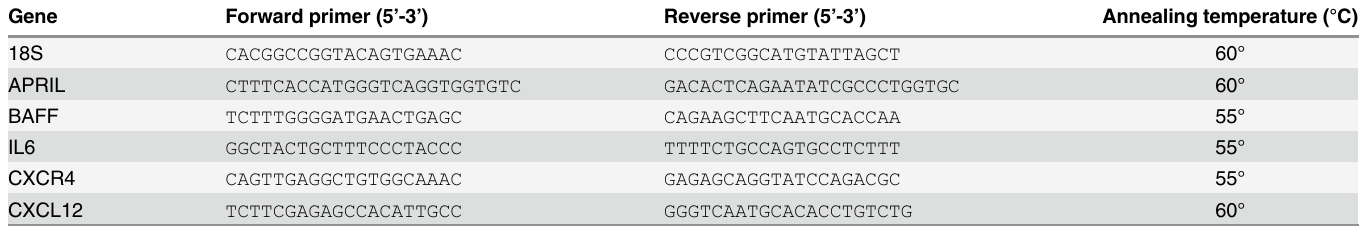
Table 1. Primer sequences and annealing temperatures used in real time PCR to detect cytokine and cytokine receptor expression in the spleens of dogs with visceral leishmaniasis.